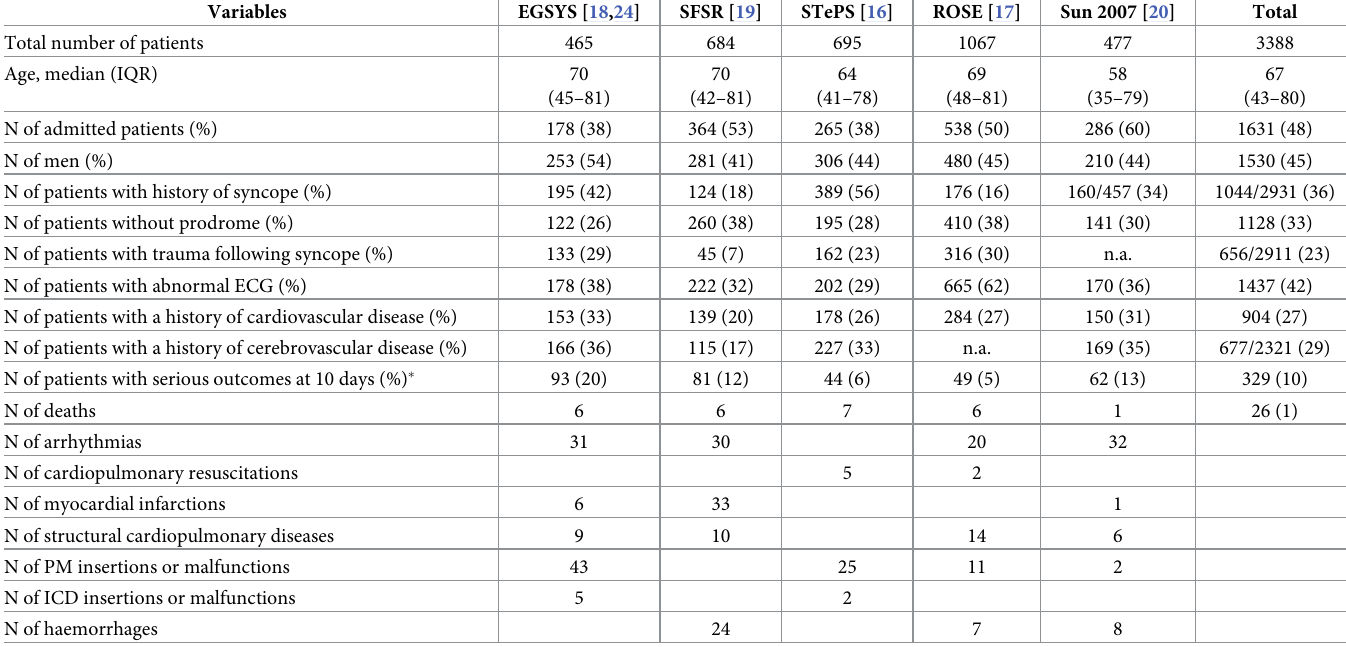
Table 1. Characteristics of the included patients. Variables EGSYS